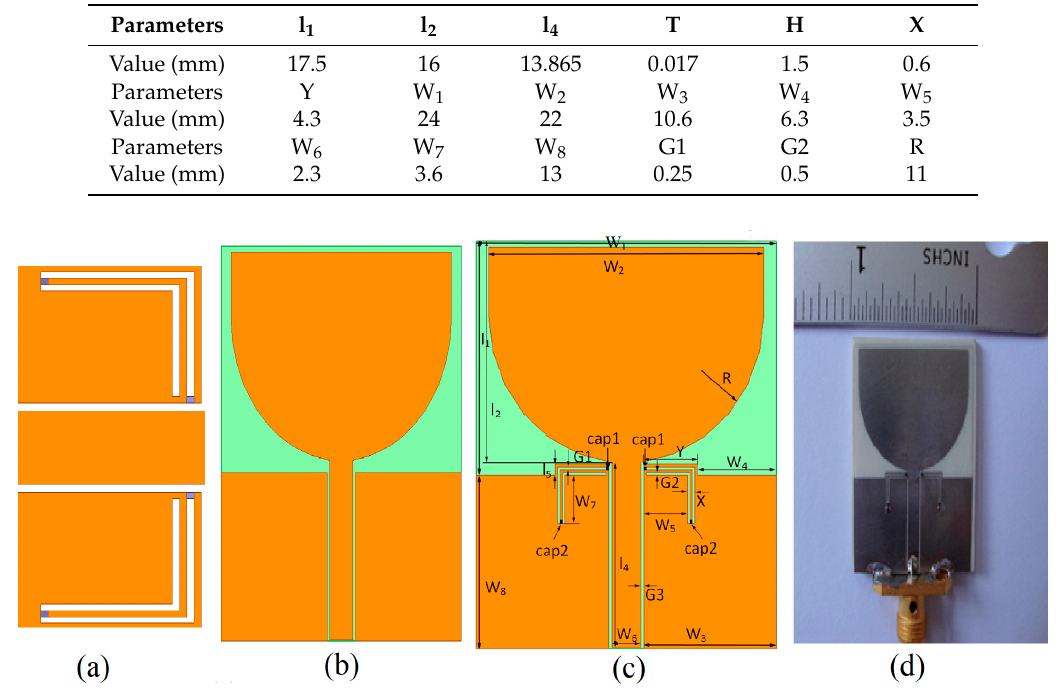
Figure 1. ( a ) Proposed miniaturized resonator; ( b ) reference UWB antenna; ( c ) UWB antenna with proposed resonator integrated; ( d ) prototype of the UWB antenna with proposed resonator integrated.